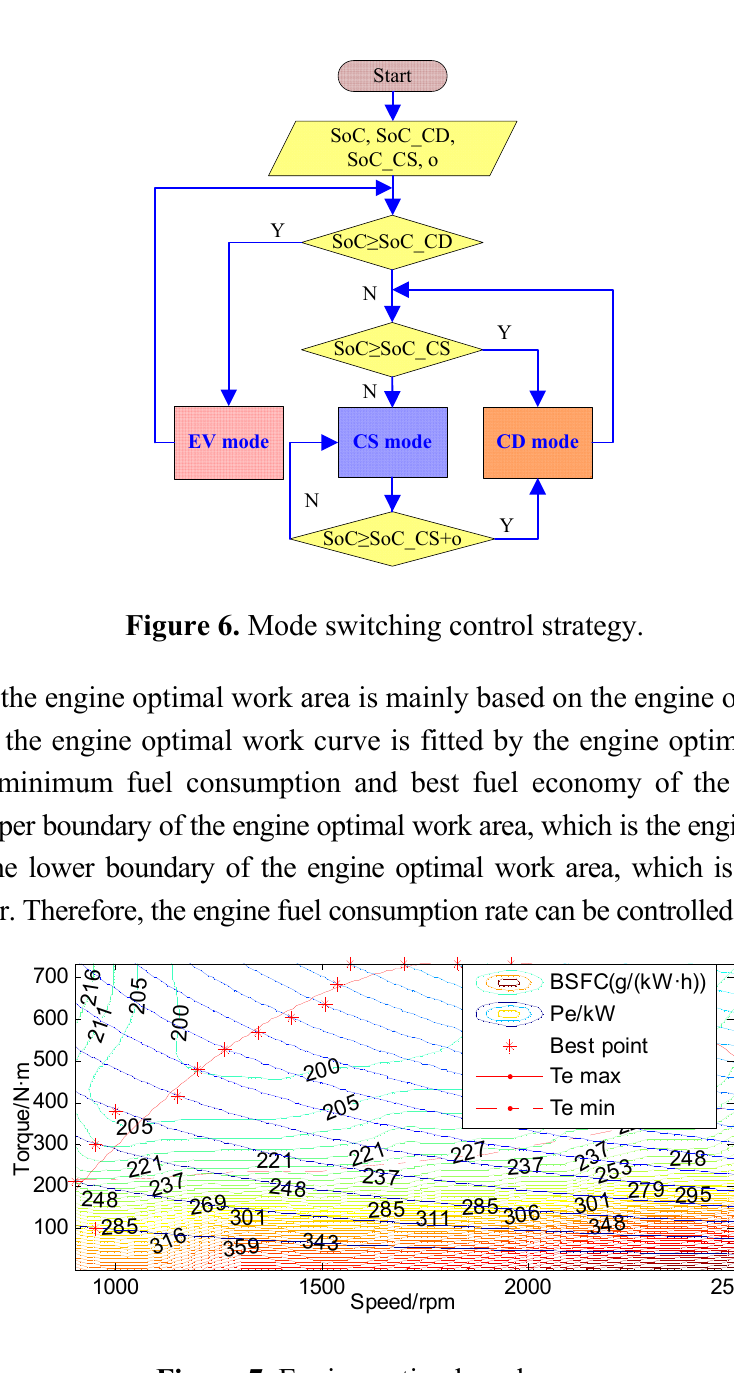
Figure 7. Engine optimal work